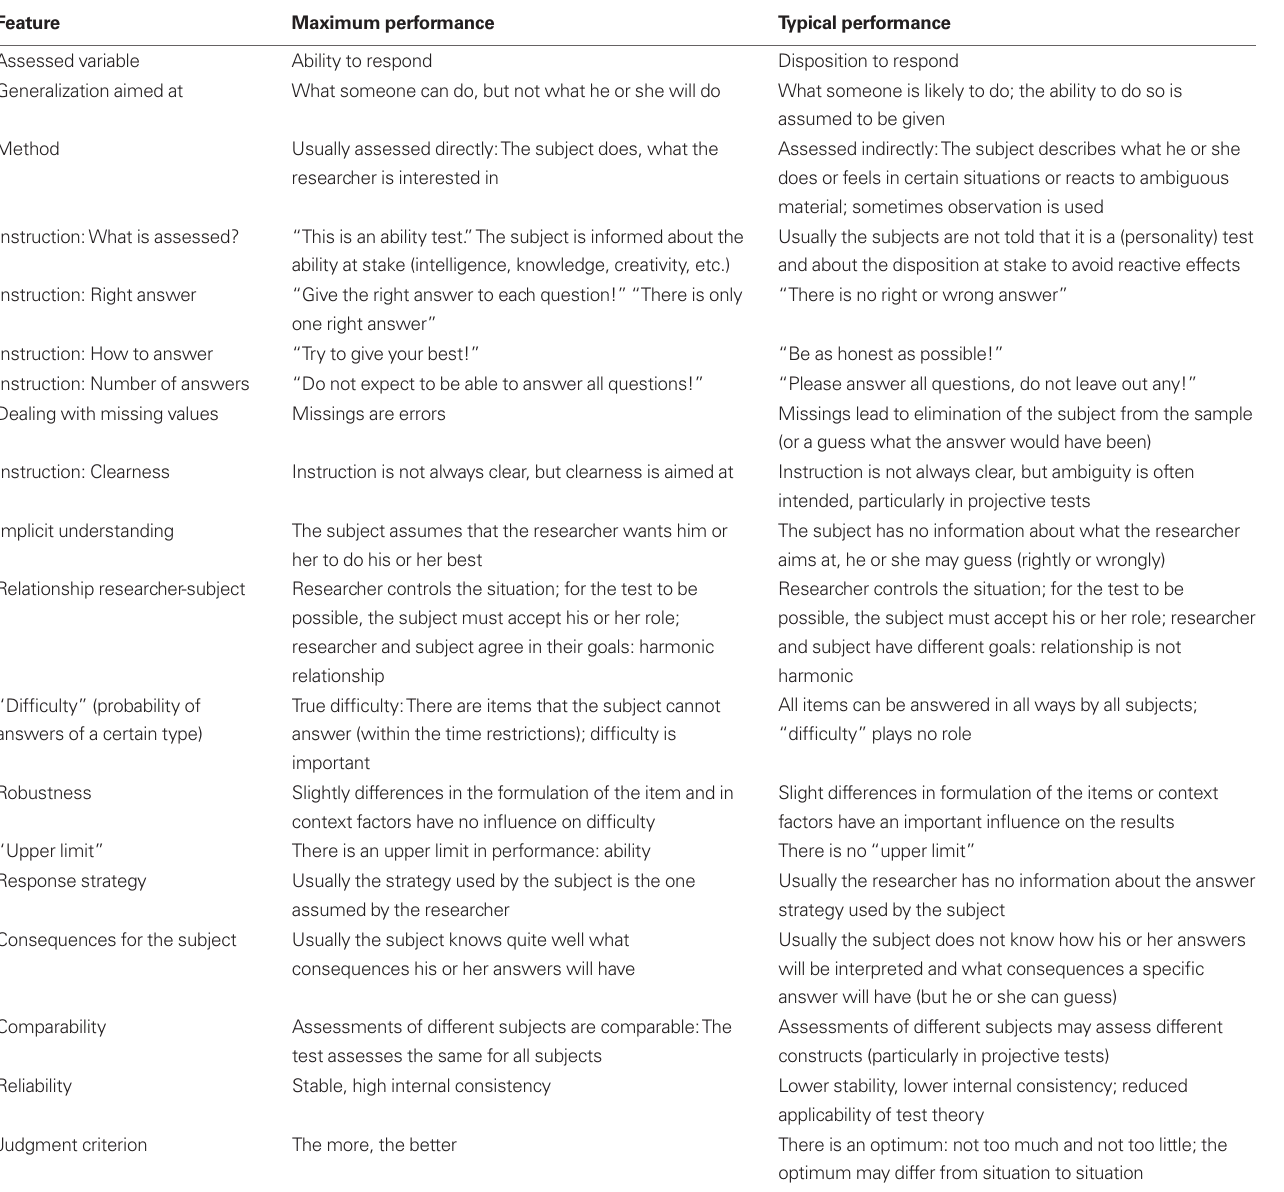
Table 2 | Differences between maximum and typical performance assessments following Fiske and Butler (1963), Cronbach (1970), Wallace (1966), Willerman et al. (1976) and others (excerpt from Patry, 1991a, pp.